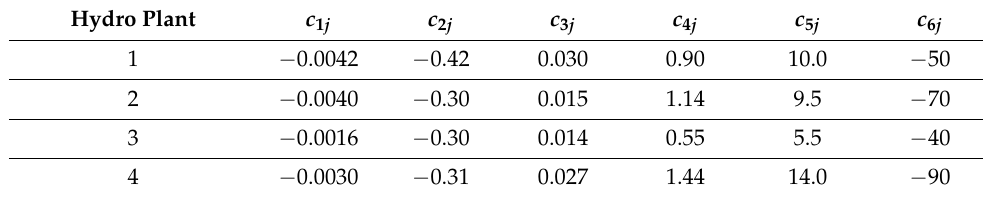
Table A2. Hydropower generation coefficients for Test System-I and II.